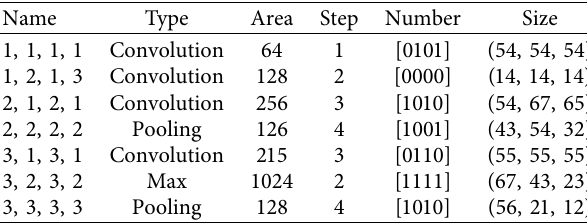
Figure 4: Sample image of Table 1: Model parameter design.